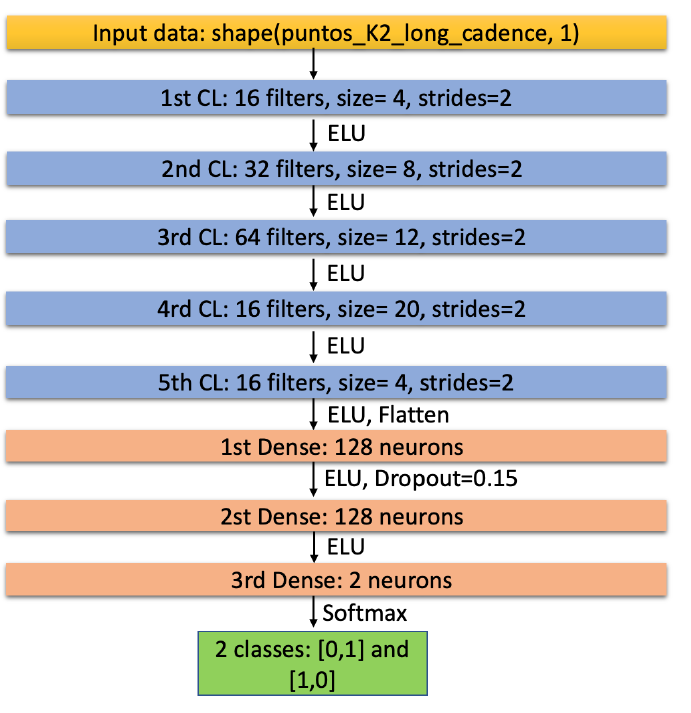
Figure 2. Graphic model of our CNN. In yellow, the input data shape; in blue, convolutional layers; in salmon, dense layers; in green, the output of the neural network. The lines between the layers indicate the activation function, the Dropout, and the Flatten layer, when